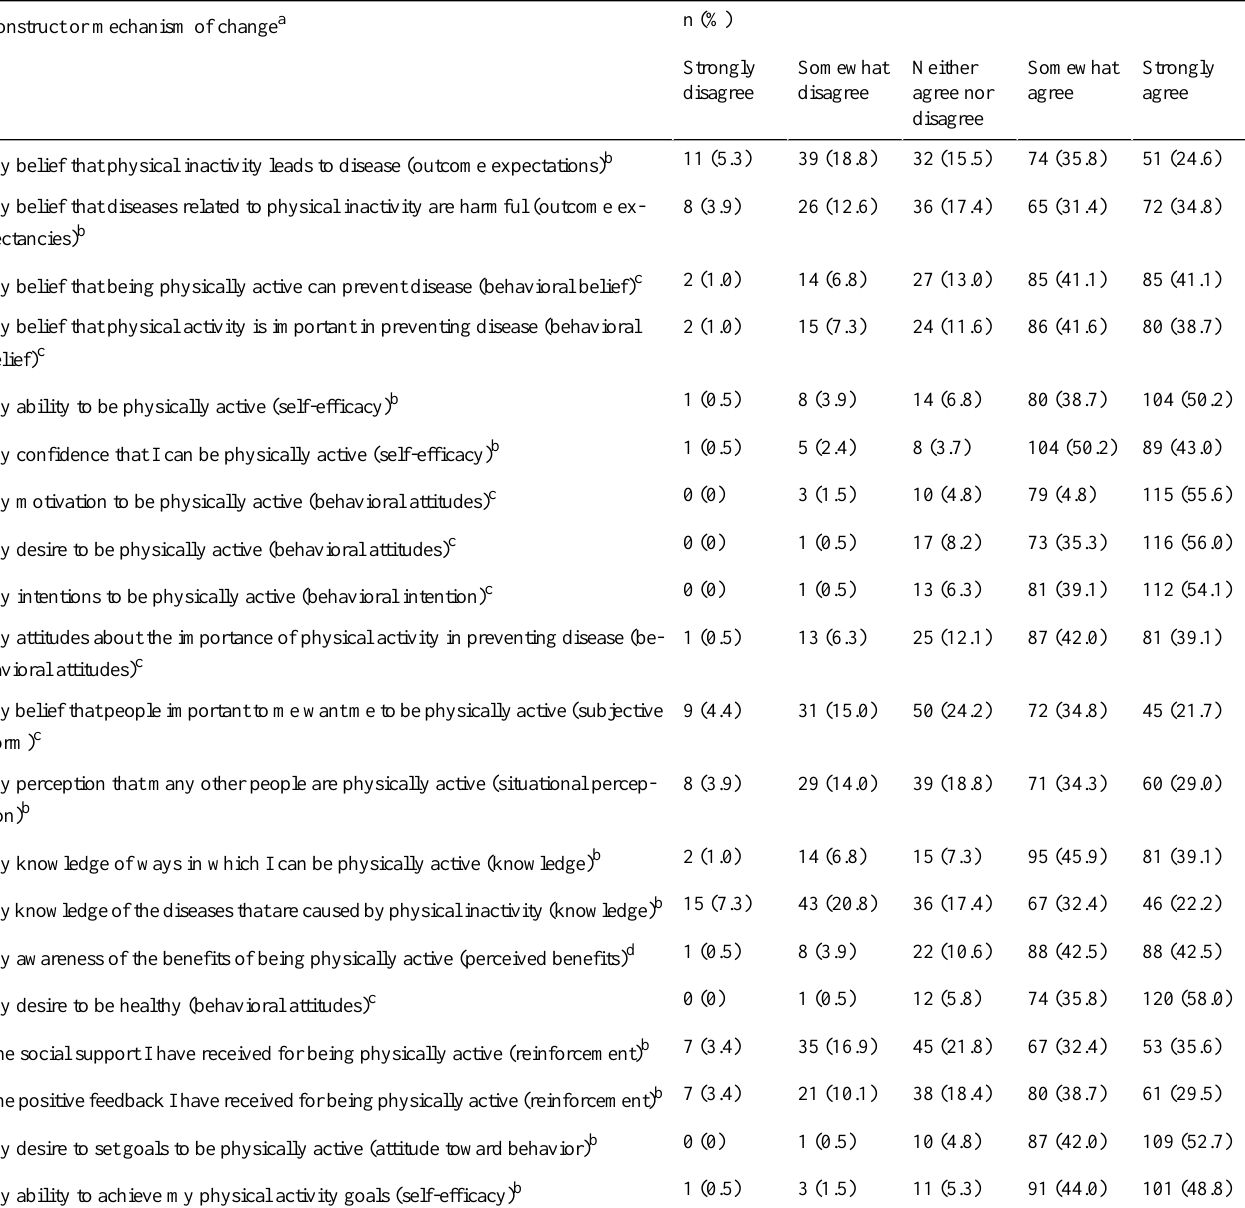
Table 2. Responses to behavior change constructs (N=207). A composite behavior theory variable was computed by summing these variables, Cronbach